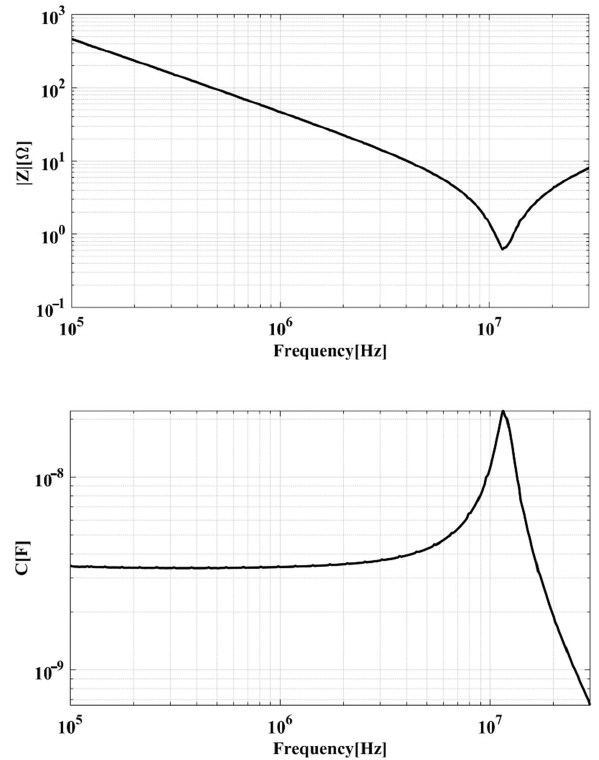
Figure 9. Example of a TVS non ‐ operating state impedance measured through VNA and its parasitic capacitance.